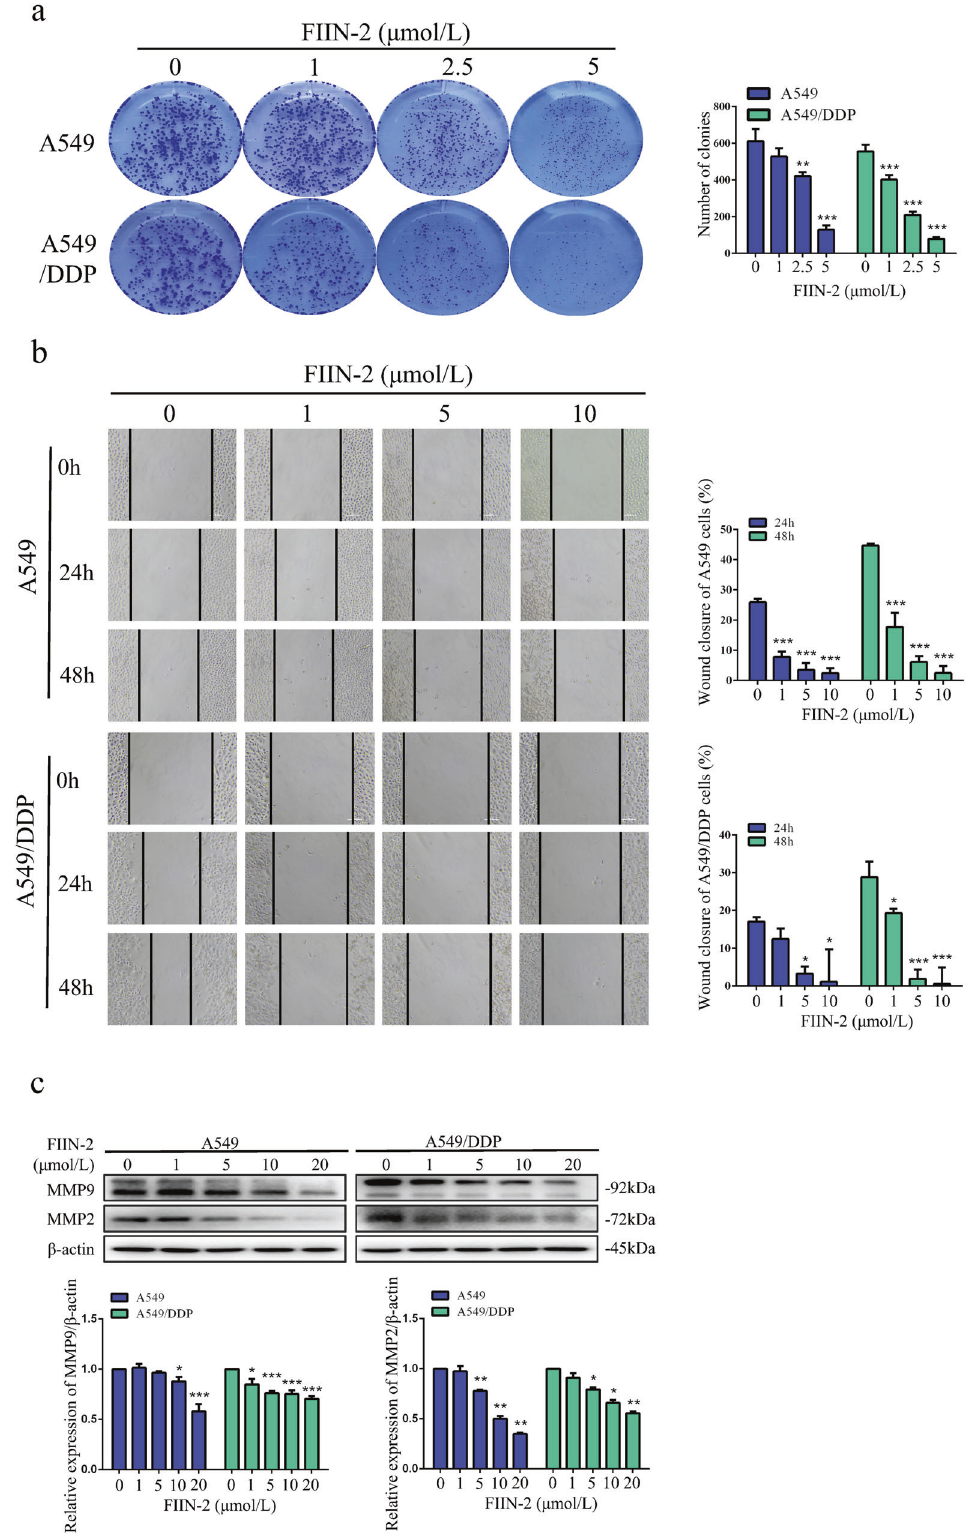
Fig. 3 FIIN-2 inhibited the colony formation and migration ability of A549 and A549/DDP cells. a A549 and A549/DDP cells were pretreated with 0 – 5 μ mol/L FIIN-2 and cultured until most individual clones exceeded 50 cells, and the colony formation of both cells was analysed. b The wound-healing assay was used to observe the effects of FIIN-2 (0 – 10 μ mol/L) on cell migration. c Cells were treated with 0 – 20 μ mol/L FIIN-2 for 24 h, and the levels of MMP2 and MMP9 were detected by western blot analysis. β -actin was used as a loading control. Each bar corresponds to the mean ± SD of three independent experiments. * p < 0.05, ** p < 0.01, *** p < 0.001; # p < 0.05, ## p < 0.01, ### p < 0.001.